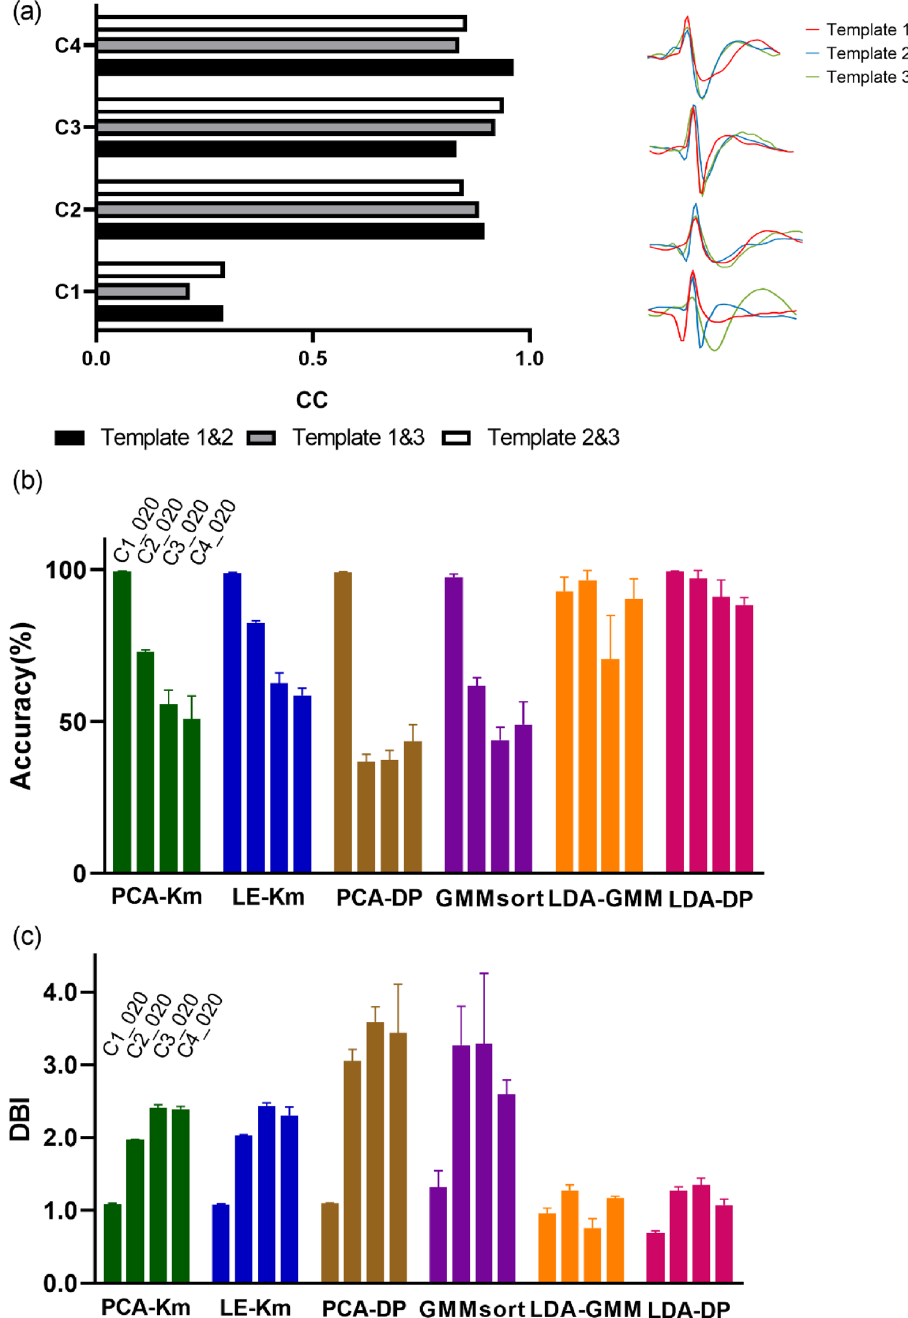
Figure 5. The sorting performance of 6 spike sorting algorithms concerning waveform similarity using the testing set C1_020, C2_020, C3_020 and C4_020. ( a ) Comparing the similarity of waveform templates in four testing sets. Left: bar graph of the correlation coefficient (CC) of the three waveform templates for four datasets. Black, gray and white respectively represent CC of template 1 and template 2, CC of template 1 and template 3, and CC of template 2 and template 3. Right: Waveform templates of each testing set. Red, blue and green represent template 1, template 2 and template 3, respectively. ( b ) Bar graph of sorting accuracy of 6 spike sorting algorithms on the testing set C1_020, C2_020, C3_020 and C4_020. Error bars represent s.e.m. ( c ) Bar graph of DBI of 6 spike sorting algorithms on the testing set C1_020, C2_020, C3_020 and C4_020. Error bars represent